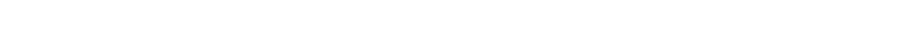
Frontiers in Immunology | Molecular Innate